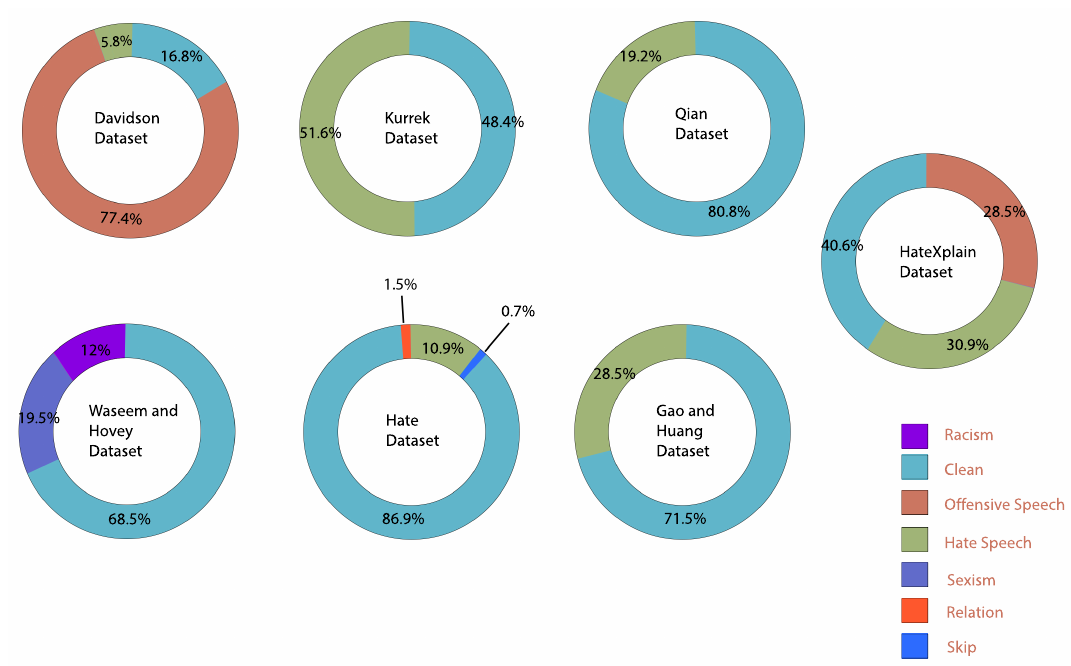
Figure 3. Dataset label